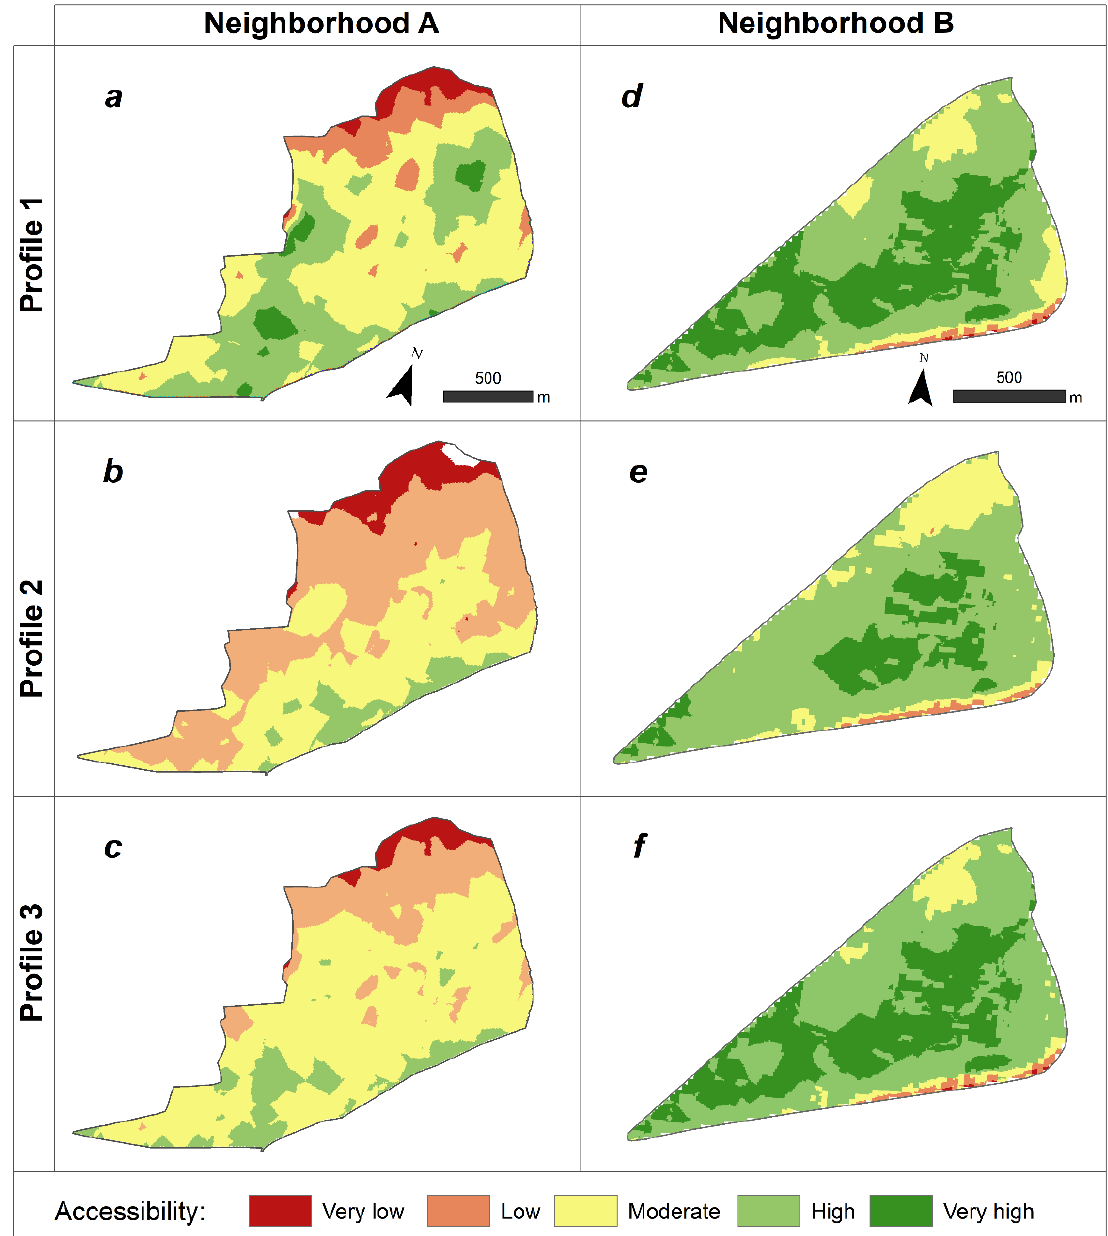
Figure 5. Potential accessibility by neighborhood and by older adult profile: healthy ( a , d ), with a chronic disease ( b , e ), and with reduced mobility ( c , f ), respectively. Maps created by the authors with ArcGIS 10.4.